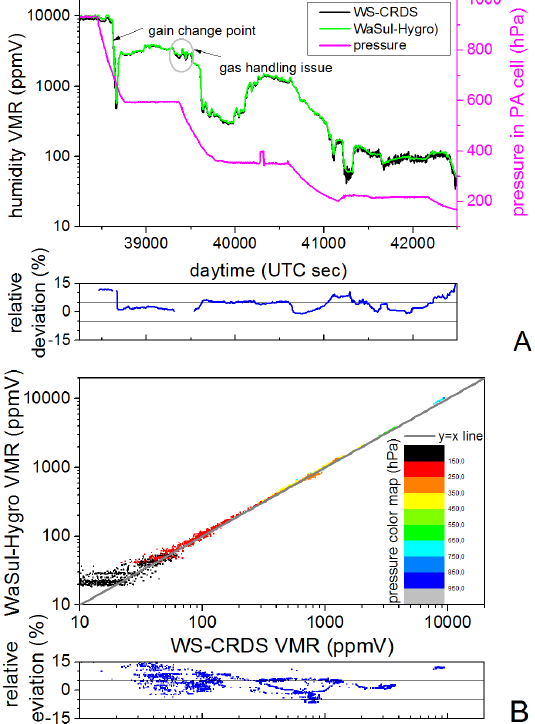
Figure 6. A representative comparison of WaSul-Hygro and FISH (DENCHAR flight, 31 May 2011). (a) is the time series of the mea- surements, where the blue shaded areas indicate when the two sys- tems were measuring the same values within the noise level; (b) is the corresponding cross plot, where the pressure is coded by color.